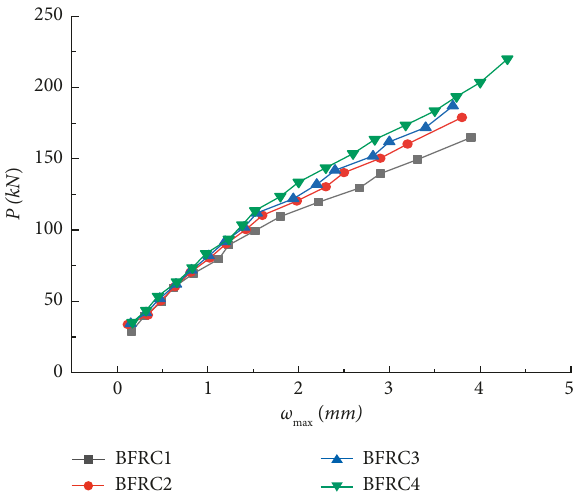
Figure 6: Load-maximum crack width curves under different volume ratios of steel fibers.